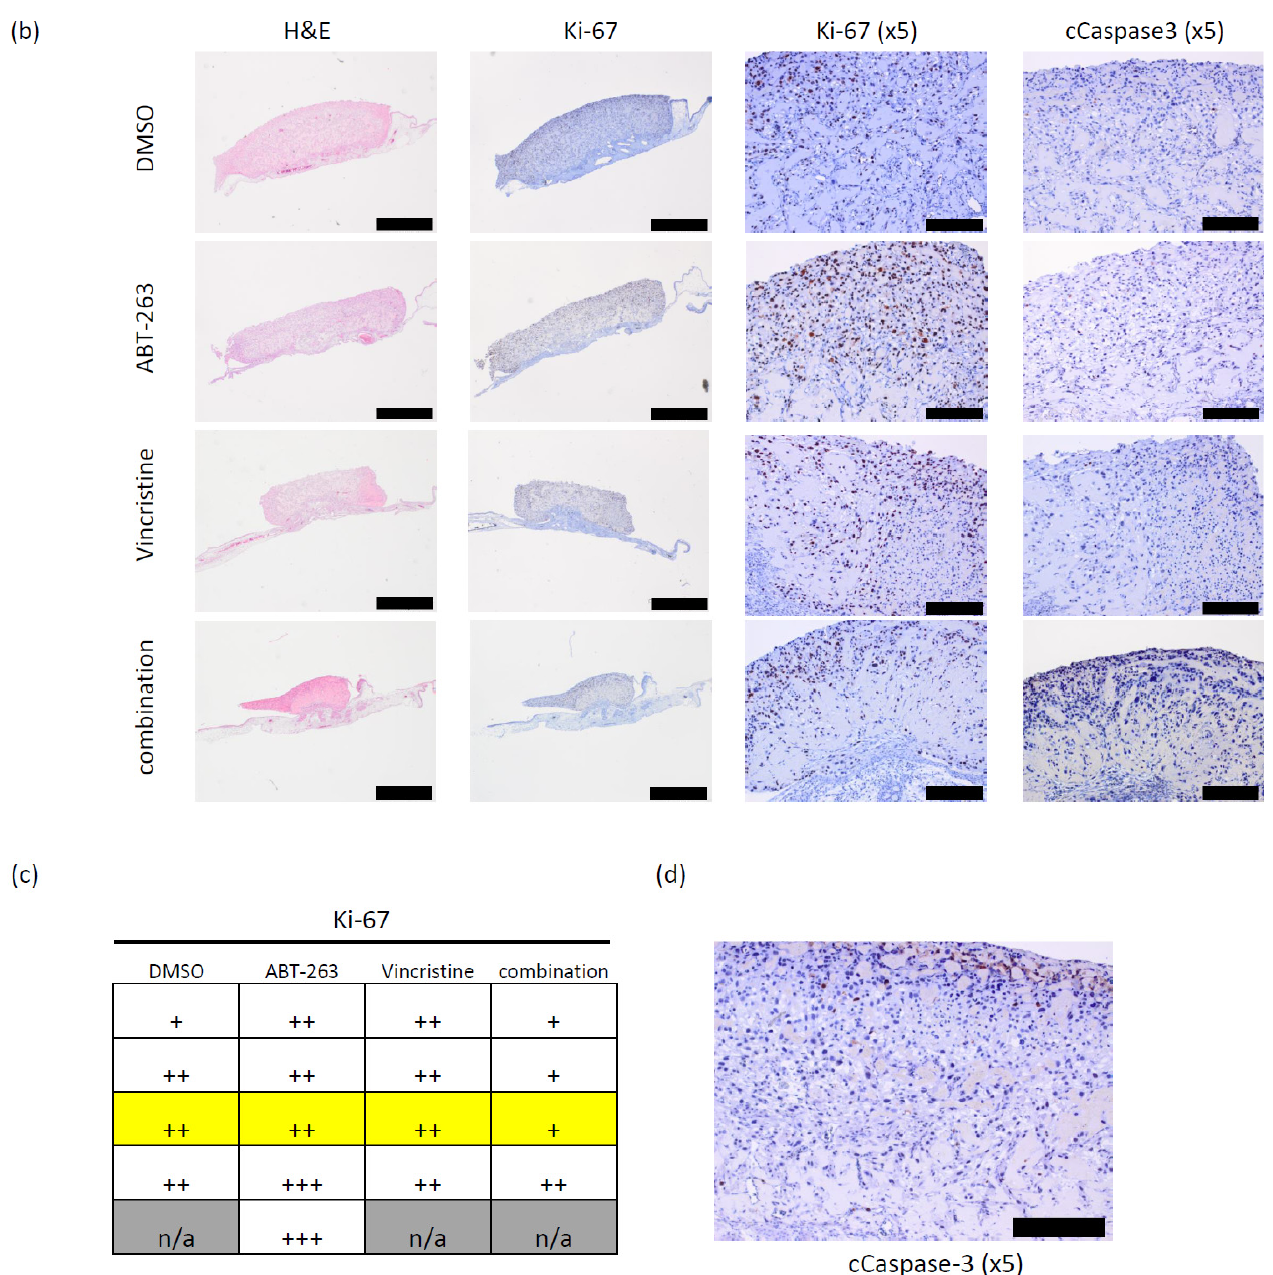
Figure 5. Combining the Bcl-XL/Bcl-2 inhibitor ABT-263 and vincristine shows superior therapeutic potential over single treatment in a chorioallantoic membrane (CAM) assay. ( a ) The surface area of double treated tumours appears to be reduced compared to mock or single treated entities. A 20:80 mixture of medulloblastoma stem cell-like cells and their differentiated progeny (SC/DC322) was seeded on the CAM of fertilized chicken eggs and were treated daily for four consecutive days with the indicated substances via local surface application (ABT-263: 5 µM, vincristine: 2.5 nM). After the aforementioned time span, the tumour surface area of all tumours (as shown on the right) was de-termined as indicated (bottom left). While a trend towards reduction is clearly visible, the reduction of surface area was statistically not significant, as determined by a one-way ANOVA test ( p -value 0.0623). ( b ) Combining ABT-263 and vincristine has an effect on tumour morphology and cycling cells, but not necessarily on apoptosis induction. Shown are representative sections taken from the tumour centre of an individual tumour per treatment group, stained for haematoxylin and eosin (H&E), haematoxylin and Ki-67 (Ki-67) or haematoxylin and cleaved Caspase-3 (cCaspase-3). Scale: